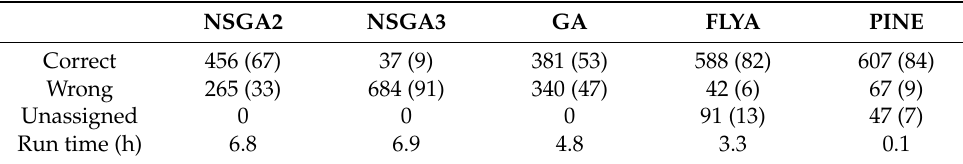
Table 6. Chemical shift assignment results for the Sso7d protein.